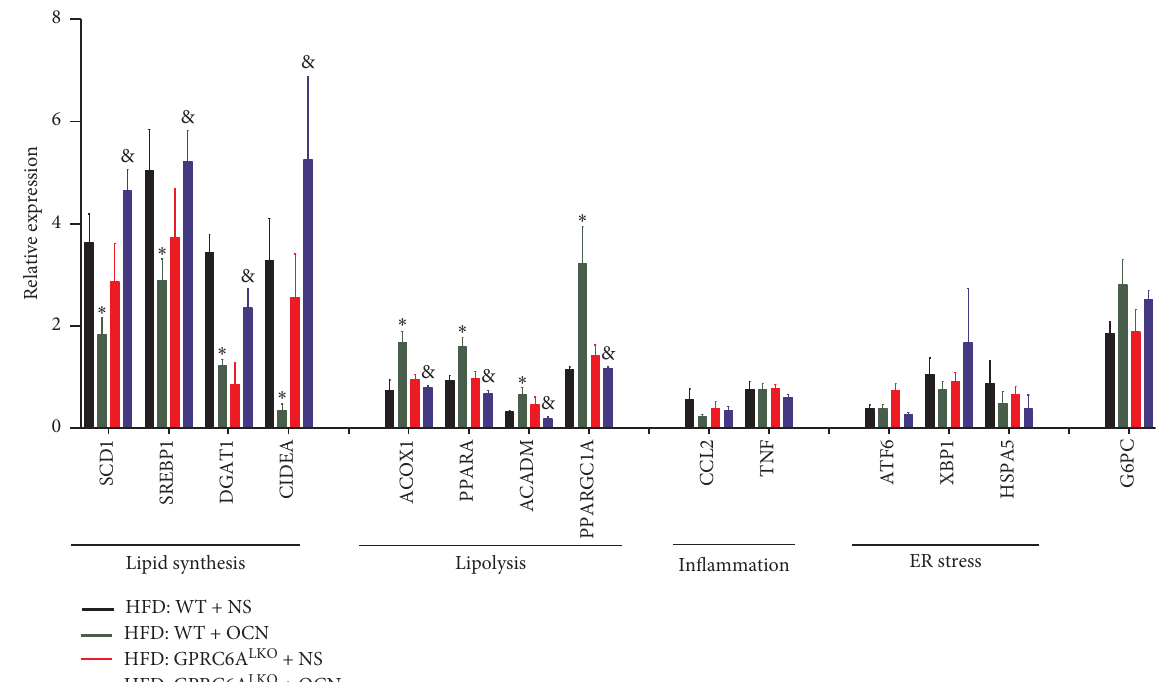
Figure 4: Relative expression of genes involved in lipid synthesis, lipolysis, inflammation, ER stress, and gluconeogenesis. Data were expressed as the mean ± SEM and were analyzed by independent-samples T -test. ∗ P < 0 . 05, HFD: WT+OCN compared with HFD: WT +NS; & P < 0 . 05, the GPRC6ALKO: HFD+OCN group compared with the WT: HFD+OCN group. ACADM, acyl-coenzyme A dehydrogenase medium chain; ACOX1, acyl-coenzyme A oxidase 1; ATF6, activating transcription factor 6; CIDEA, cell death-inducing DNA fragmentation factor alpha subunit-like effector A; CCL2, chemokine (C-C motif) ligand 2; DGAT1, diacylglycerol O-acyltransferase 1; G6PC, glucose-6-phosphatase catalytic subunit; HSPA5, heat shock protein 5; PPARGC1A, peroxisome proliferator-activated receptor gamma coactivator 1 alpha; PPARA, peroxisome proliferator-activated receptor alpha; SCD1, stearoyl-coenzyme A desaturase 1; SREBP1, sterol regulatory element binding transcription factor 1; TNF, tumor necrosis factor; XBP1, X-box binding protein